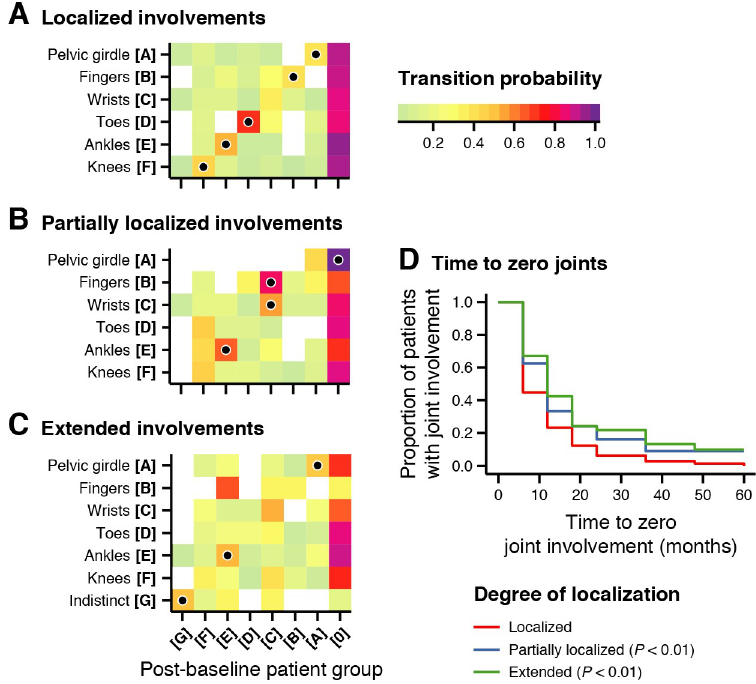
Fig 5. Patient groups and localizations predicted disease course. (A) Heat maps showing the probability (colors; bottom legend) that patients in a baseline or reference patient group (y-axis) with localized involvement transition to patient groups at any visit from six months to five years (x-axis). Filled circles denote significantly enriched transitions ( P < 0.05; Holm-Bonferroni–adjusted). (B) Same as panel A, but for patients with partially localized involvement. (C) Same as panel A, but for patients with extended involvement. (D) Time to zero curves, by degree of localization (line types; bottom legend), showing the proportion of patients continuing to have joint involvement (y-axes) after given visits after baseline (x-axes). P values represent those for HRs calculated by a Cox proportional hazards model. HR, hazard ratio.